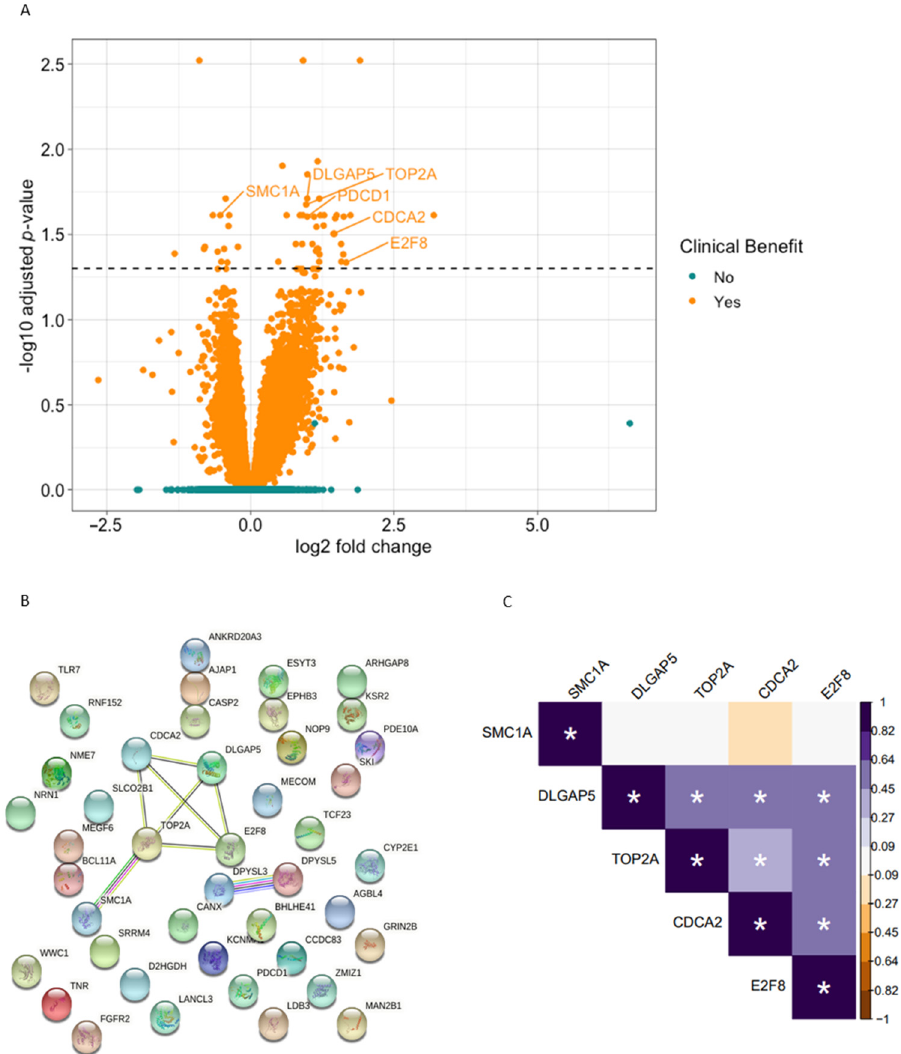
Figure 1. Differentially expressed genes (DEGs) between baseline and on-treatment samples. ( A ) Vol- cano plot of DEGs in patients with (orange) and without clinical benefit (green). The dashed line indicates the significance threshold (padj = 0.05). In patients with clinical benefit, 51 DEGs were identified. No significant genes were found in patients without clinical benefit. ( B ) STRING protein- protein interaction analysis on the DEGs identified in patients with clinical benefit. Yellow lines indicate text mining evidence, black lines co-expression evidence, green lines neighborhood evidence, blue line co-occurrence evidence, purple line experimental evidence and light blue lines database evidence. ( C ) Correlation heatmap summarizing the correlations between expression levels of the identified cell cycle/proliferation genes. Baseline and on-treatment samples of both patients with and without clinical benefit were included in this analysis. Colors refer to the Pearson’s correlation coefficient. Asterisks indicate a p -value ≤